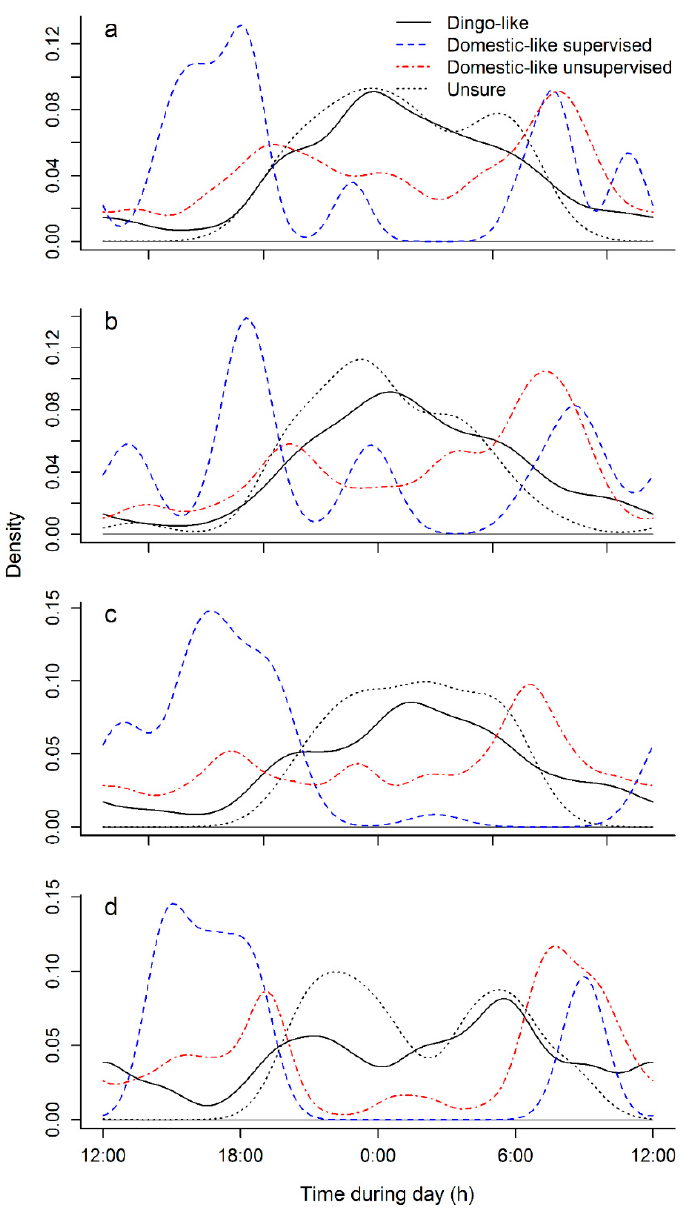
Figure 3. Density curves illustrating the daily activity patterns of dingo-like, domestic-like supervised, domestic-like unsupervised and unsure dogs, based on a camera trap study conducted in the NPA of Queensland, Australia, for ( a ) session 1 (9-May-2016 to 18-Aug2016), ( b ) session 2 (19-Aug-2016 to 16-Nov-2016), ( c ) session 3 (17-Nov-2016 to 14-Feb-2017) and ( d ) session 4 (15-Feb-2017 to 15-May-2017).